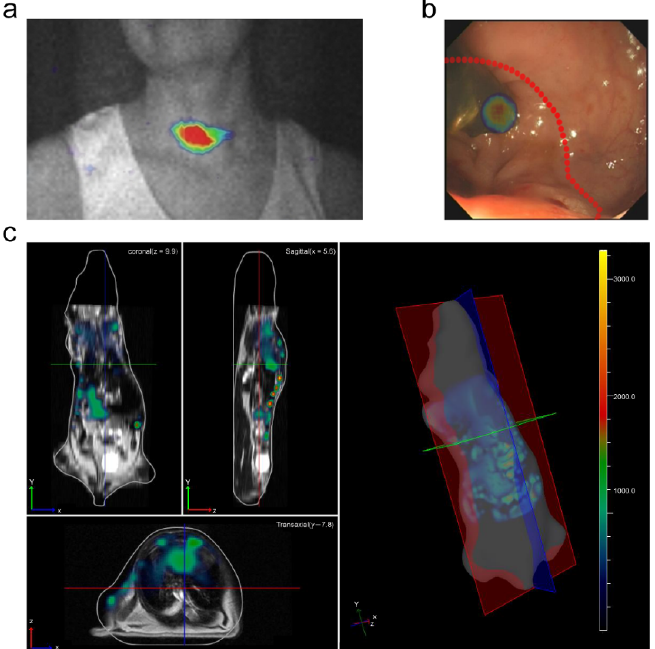
Figure 2. Examples of imaging technology using Cherenkov luminescence. ( a ) First Cherenkov luminescence image (CLI) of a thyroid patient. Adapted with permission from Ref. [80] 2013 SPIE. ( b ) CLE images overlaid with white ‐ light photographs. Adapted with permission from Ref. [104] 2015 Springer Nature. ( c ) Whole body CLT coregistered with magnetic resonance imaging. Adapted with permission from Ref. [71] 2011 Optica Publishing Group.